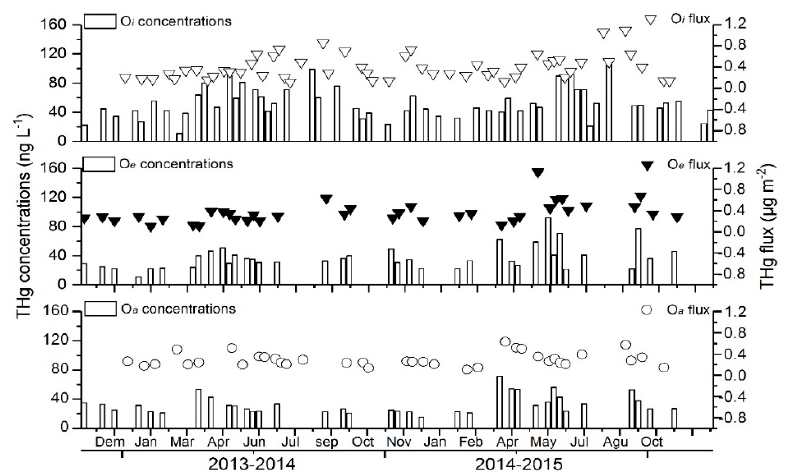
Figure 5. THg concentrations and fluxes in the soil percolates collected in the study forest stand from 2013 to 2015. Table 3. The corrected concentrations and fluxes of THg and MeHg in the runoff, forest floor percolates and water during the sampling period from 2013 to 2015.